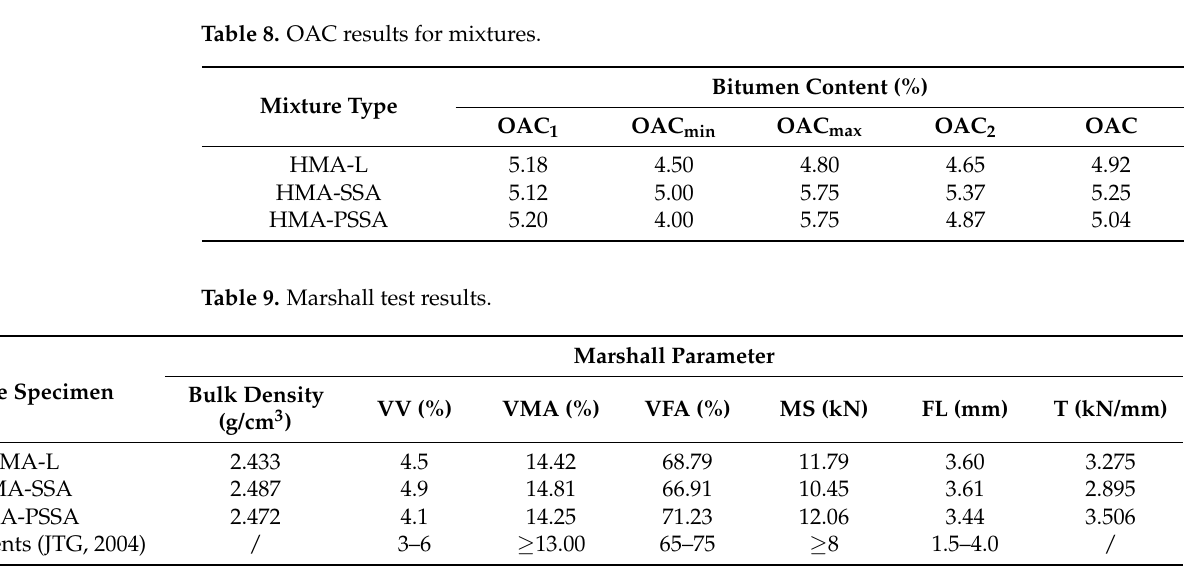
Figure 13. Fitting curves of drawing strength with adhesion work and stripping work.